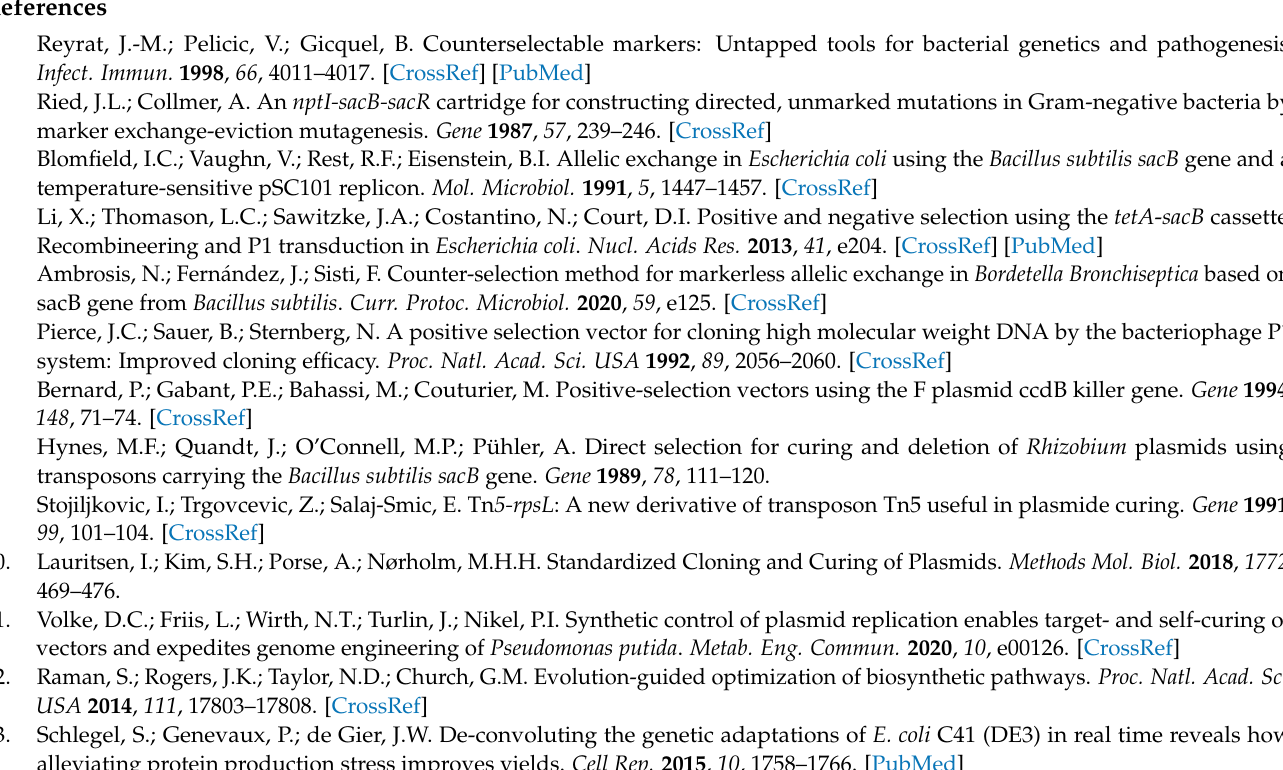
curing experiment shown in Figure 1. Figure S2: Nucleotide sequence of the target plasmid used in the plasmid exchange experiment shown in Figure 2. The positions and sequences of the PCR primers specific for the target plasmids (ZKRS-s and ZKRS-as) used in Figure 2e are also shown. Figure S3: Nucleotide sequence of the substitute plasmid, pACYC184, used in the plasmid exchange experiment shown in Figure 2. The positions and sequences of the PCR primers specific for the substitute plasmids (Tet-s and Tet-as) used in Figure 2e are also